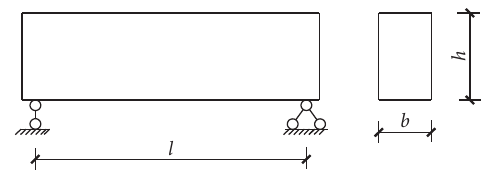
Figure 25: Schematic diagram of the single-span deep flexural